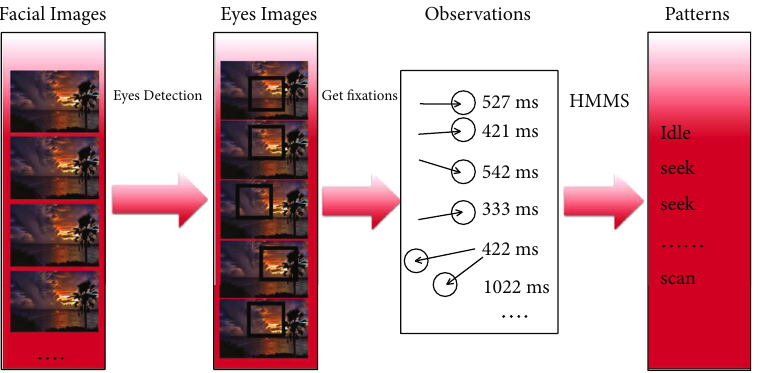
Figure 3: Flow chart of image feature